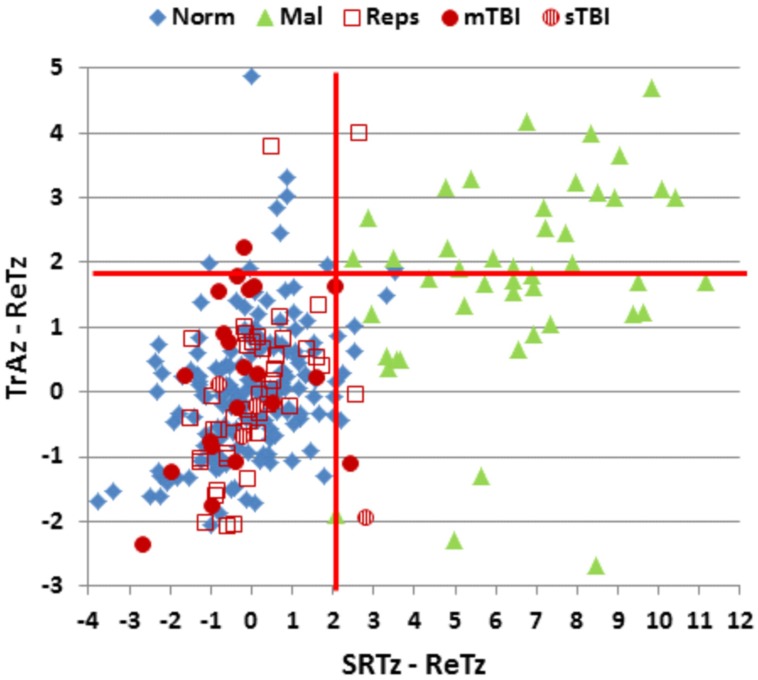
Differences in ReT z-scores on the C-SST and two processing speed tests in malingering and control conditions. Ordinate: Differences between ReT z-scores and z-scores on the Trail Making Test, part A (TrAz). Abscissa: Differences between Log ReT z-scores and Simple Reaction Time z-scores (SRTz). Horizontal and vertical red lines show the upper limits (p < 0.05) of the difference distribution in the normative control group of 187 participants (Norm). See Figure 2 for group membership specifications.